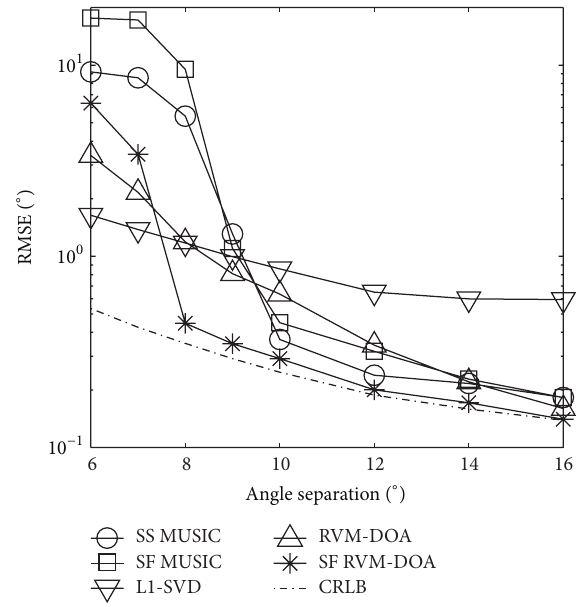
Figure 3: Averaged DOA estimation RMSE of two 7dB coherent sources with 30 snapshots when their angle separation